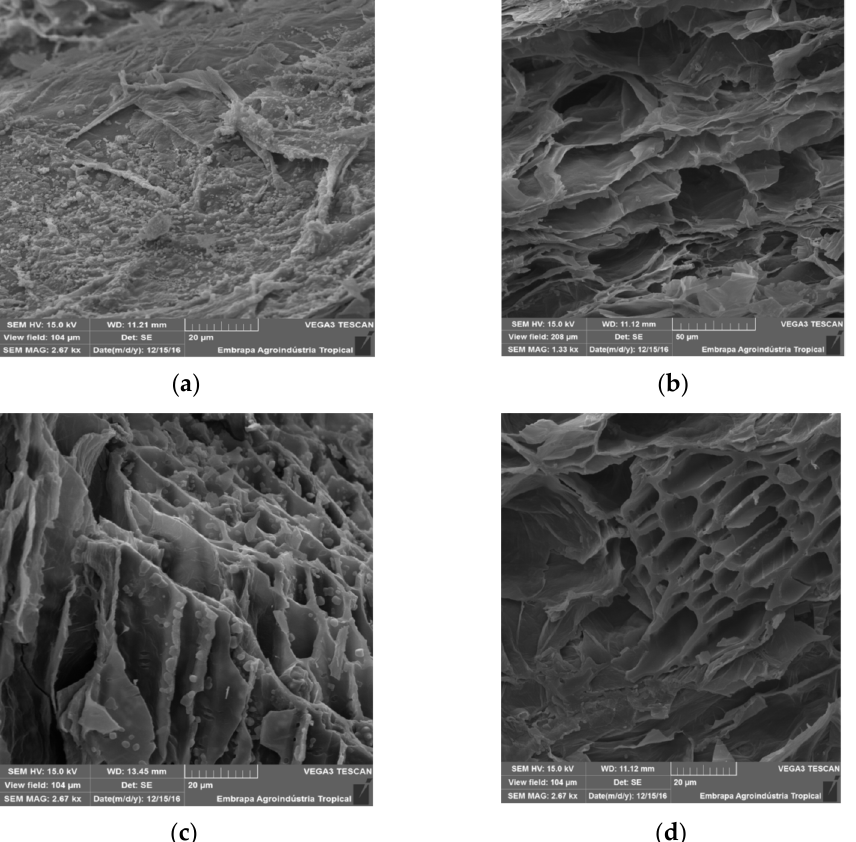
Figure 2. Images of biochar from sun-dried green coconut husk, obtained by scanning electron microscopy, brand Tescan, model Vega 3. ( a ) Epicarp of the fruit with details of the sclerenchyma, very fibrous and rich in recesses. ( b ). Fruit mesocarp showing parenchyma with plant cells of different sizes. ( c ) Longitudinal sections of the vascular cambium of the mesocarp, showing long, juxtaposed, thick-walled vessels. ( d ) Vessel bundle in the cross-section, with details for highly lignified vessels. Table 3. Means of soil chemical attributes 2 years after application of sun-dried green coconut husk